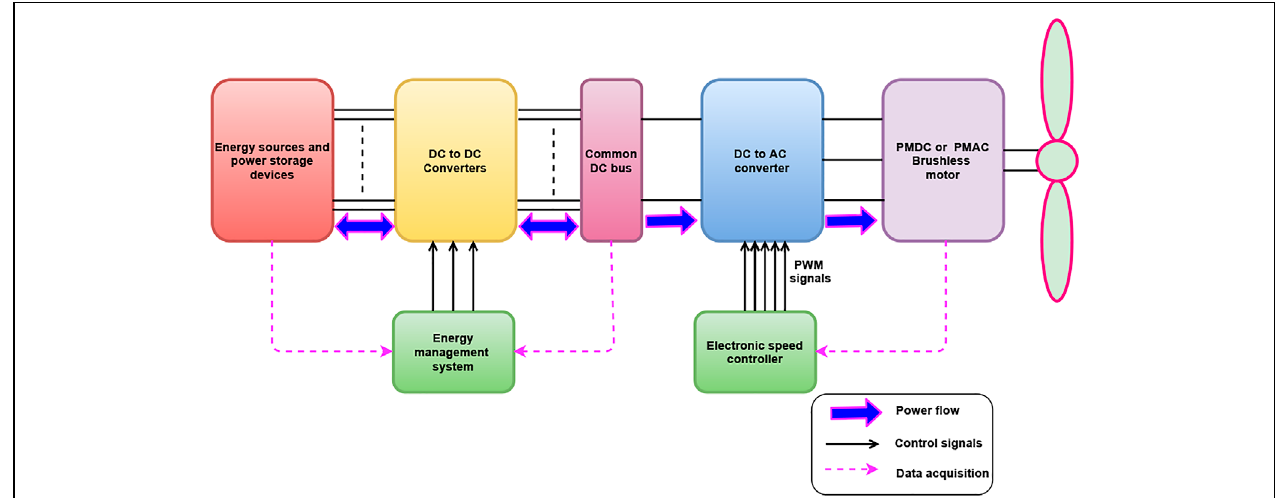
FIGURE 2 | Electric powered UAV propulsion system Block